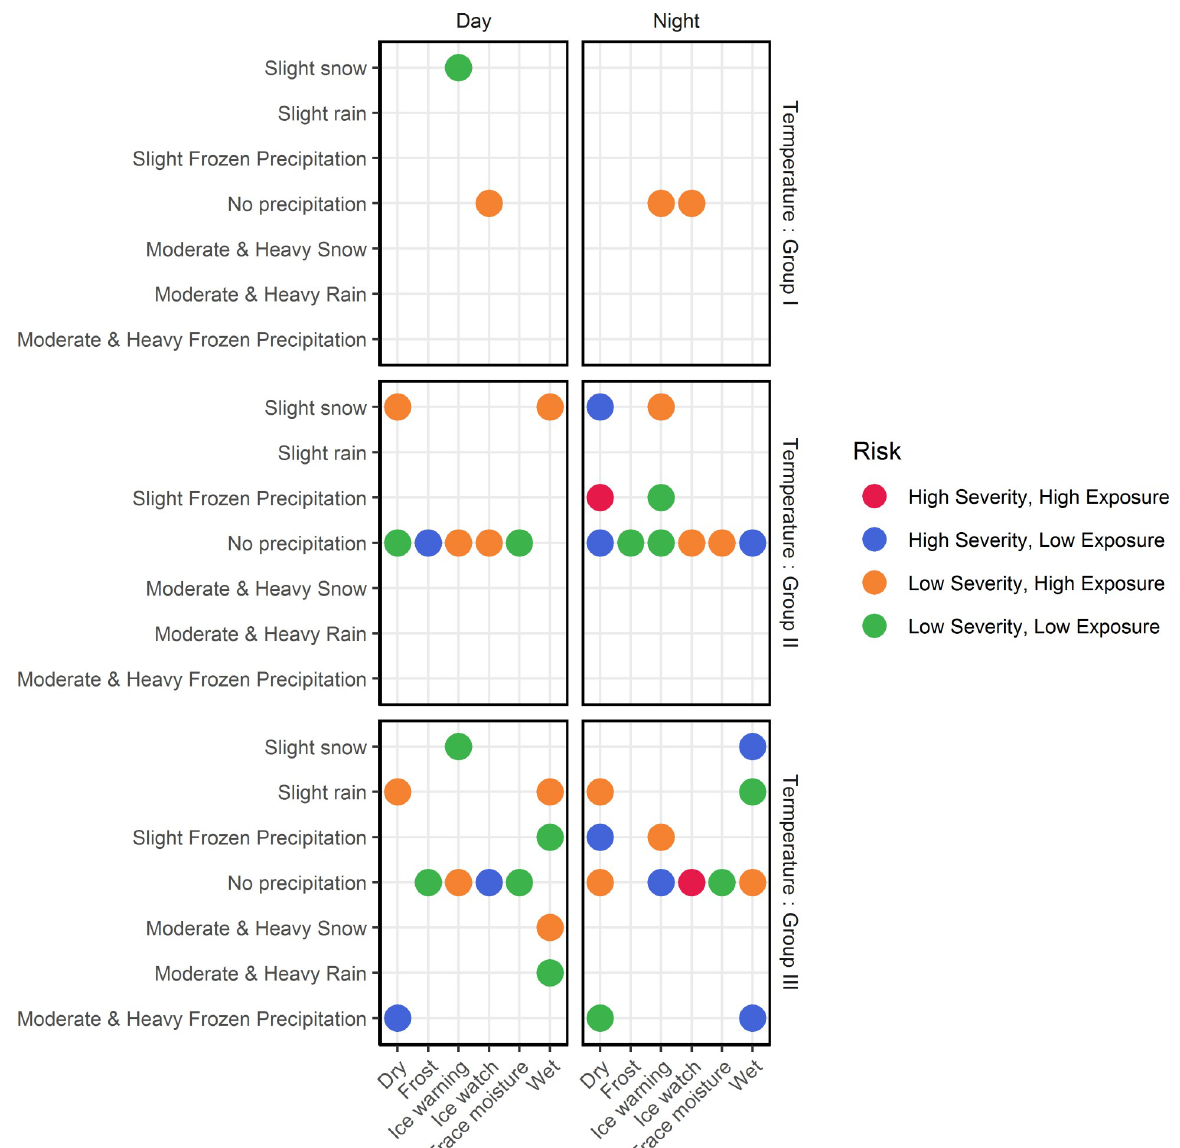
Fig 14. Classification of each road-weather combination under the prevailing traffic